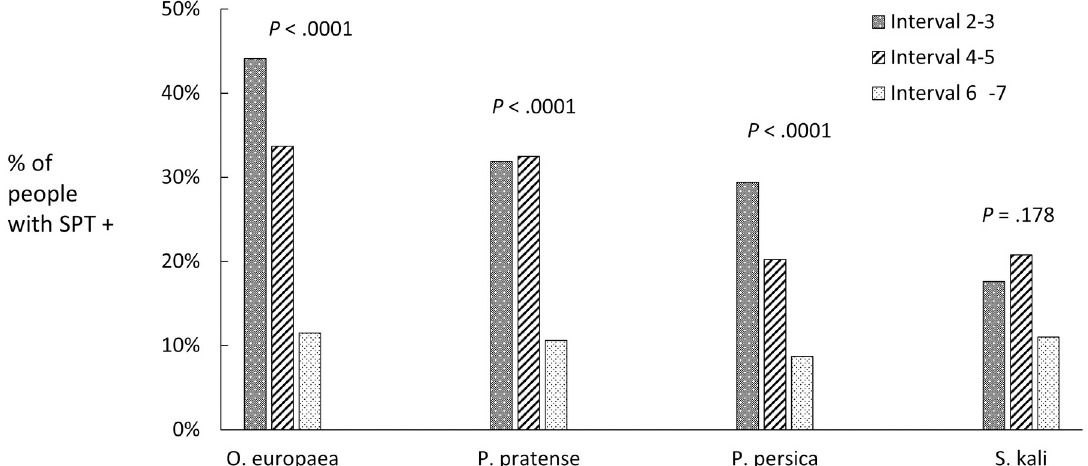
Fig 3. Sensitisation to the four most prevalent pollen allergens, by age groups. SPT: skin prick test, interval 2–3: 21–40 y.o., interval 4–5: 41–60 y.o., interval 6–7: 61–83 y.o.